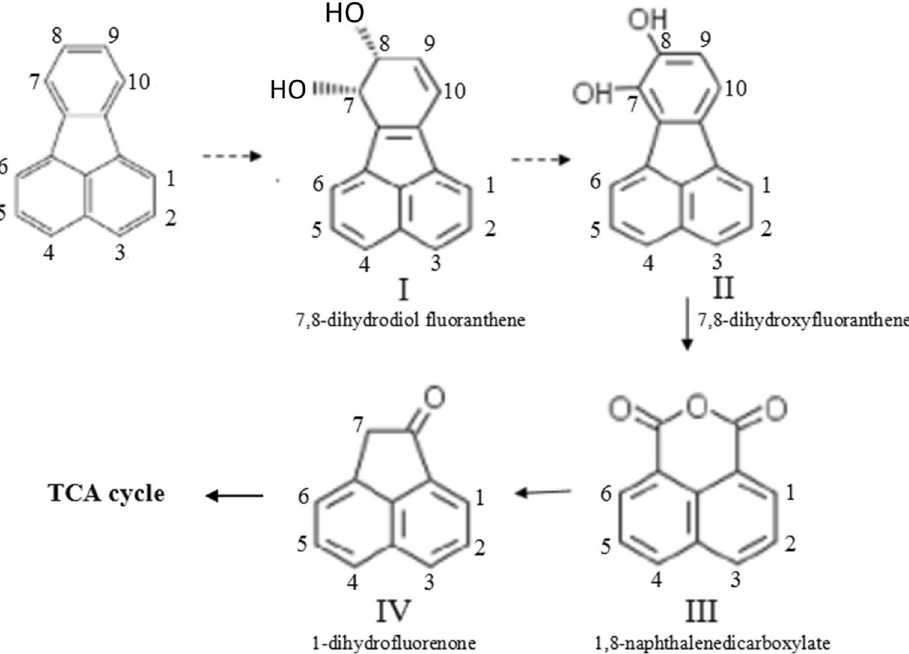
Figure 6. A proposed degradation pathway of fluoranthene in the strain DN1. The dotted arrow represents a putative degradation reaction based on RHD, and the solid arrow suggesting the degradation step was deduced by the analysis of the previous detected metabolites (He et al.